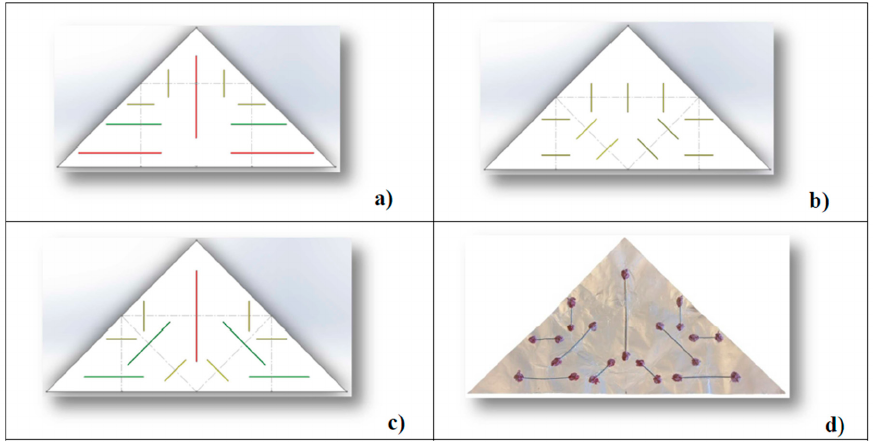
Figure 1. A sketch of an aluminum sail in configuration 1 ( a ), 2 ( b ), and 3 ( c ). Prototype of configuration 3 is reported in section ( d ). 3 is reported in section ( d